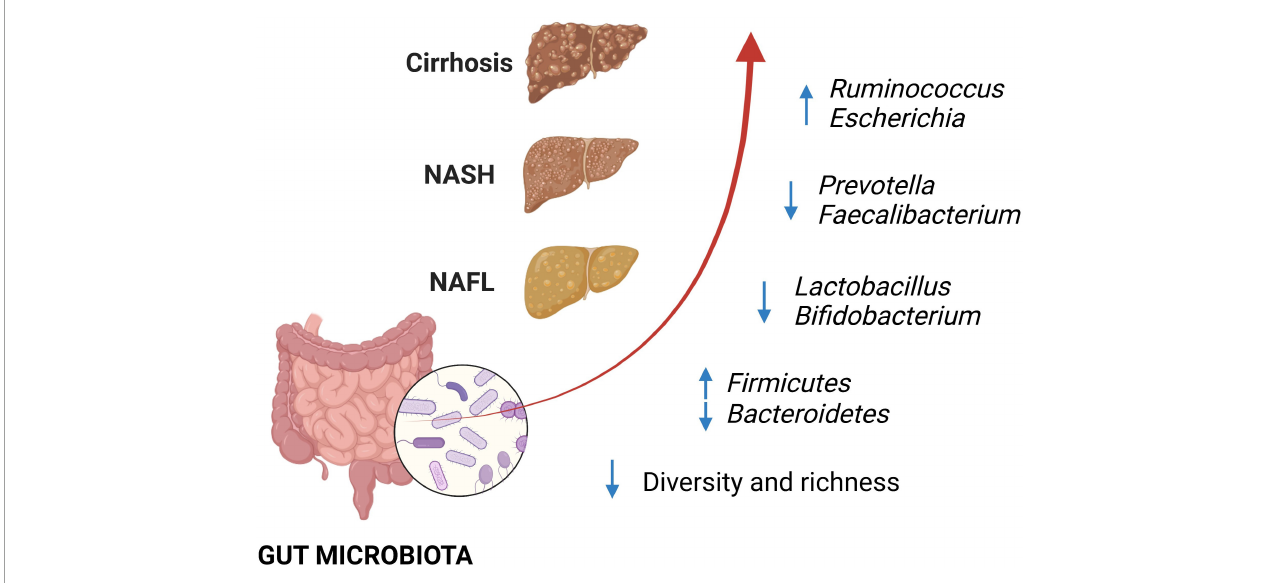
FIGURE1 Changes in gut microbiota have been associated with non-alcoholic fatty liver disease (NAFLD), with progressive alteration of some bacterial components, according to the fibrosis degree. Loss of bacterial diversity and depletion of beneficial bacteria such as Lactobacillus and Bifidobacterium have been described with the progression of NAFLD, together with the increase in Ruminococcus and Escherichia in patients with advanced fibrosis. NAFLD, non-alcoholic fatty liver; NASH, non-alcoholic steatohepatitis.